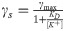
Permeability ratio of monovalent ions and the relationship between [K+] and conductance.(A) Permeability ratios were determined by using the Goldman-Hodgkin-Katz (GHK) equation for monovalent cations. I/V relationships were obtained from outside-out patches with Cs+, Na+ or Li+ on the cytoplasmic side and K+ on the extracellular side. The reversal potentials were compensated a posteriori for the liquid junction potentials resulting from assymetric ion composition across the outside-out patch. The monovalent pipette solutions did not contain Ca2+ or Mg2+ ions. (B) Conductance as a function of K+ ion concentration ([K+]) in cell-attached patches (n = 3 patches for each concentration). The pipette solutions did not contain Ca2+ or Mg2+. The comparison across concentrations was performed for a fixed driving force of 40 mV. The conductance versus [K+] data were curve-fitted using the Michealis-Menten equation: γs=γmax1+KD[K+]. The junction potentials were ignored because they were within 0–2 mV. Single channel traces corresponding to 10 mM, 30 mM, 100 mM and 300 mM are shown in the inset.